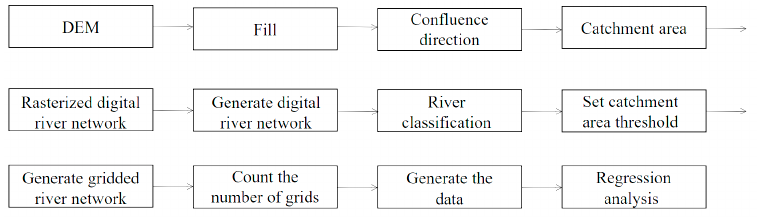
Figure 3. Flow chart of river network extraction.